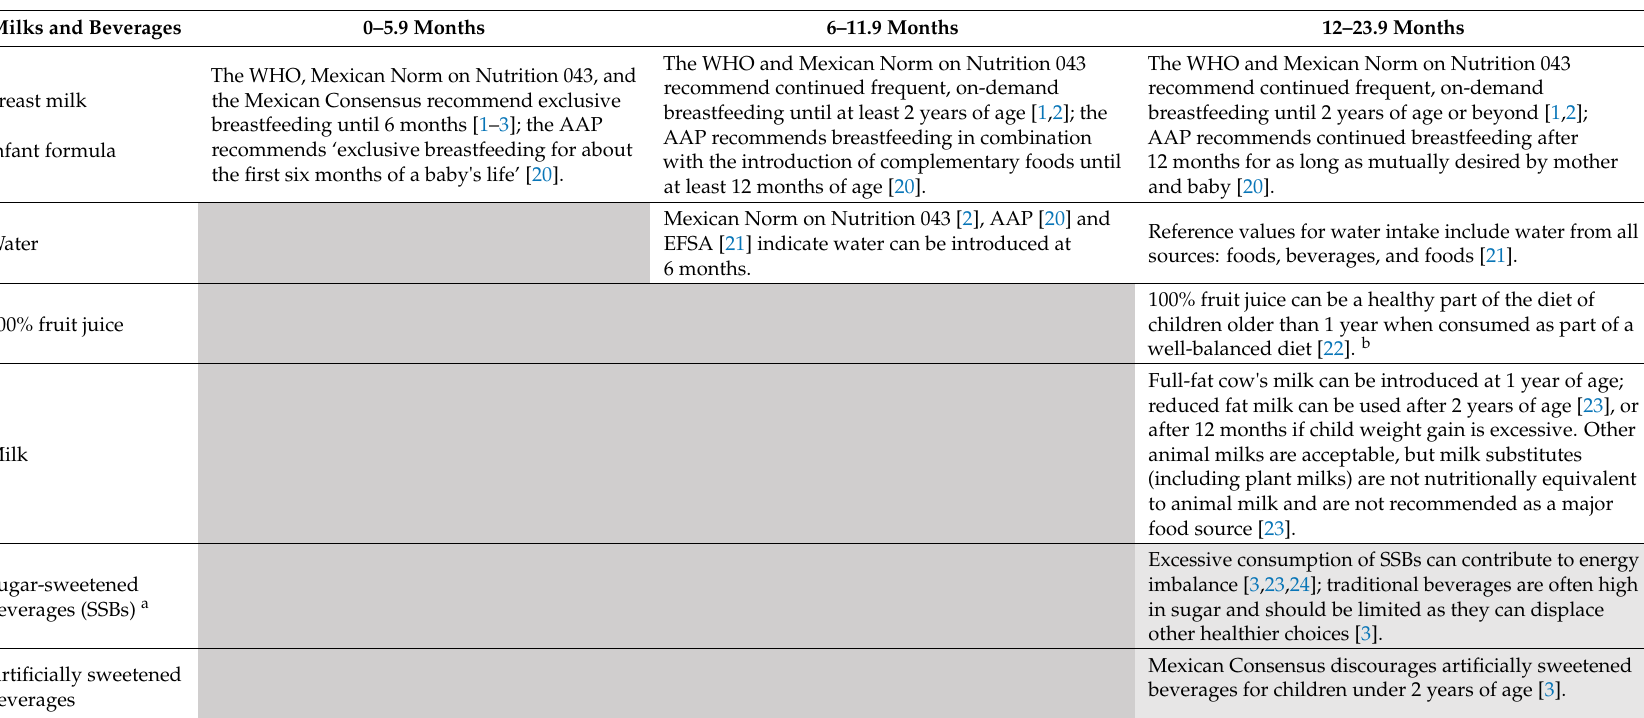
Table 1. Classification of milk and beverages as recommended or inappropriate for Mexican infants and toddlers by age.